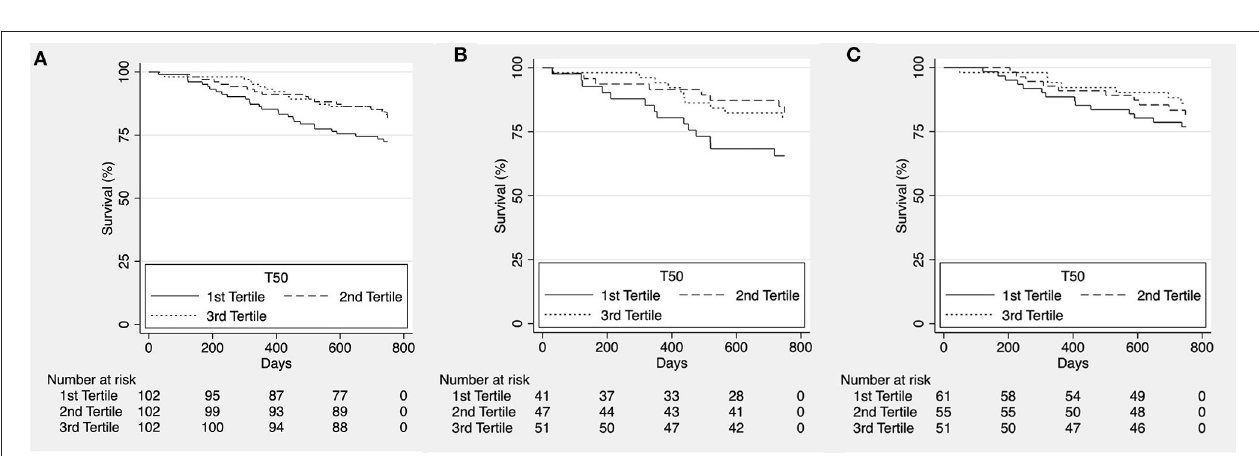
FIGURE 2 | Kaplan-Meier estimates for overall survival according to T 50 tertiles for the whole cohort [ (A) , p = 0.068], patients with ischemic heart failure with reduced ejection fraction [HFrEF; (B) , p = 0.095] and patients with non-ischemic HFrEF [ (C) , p =